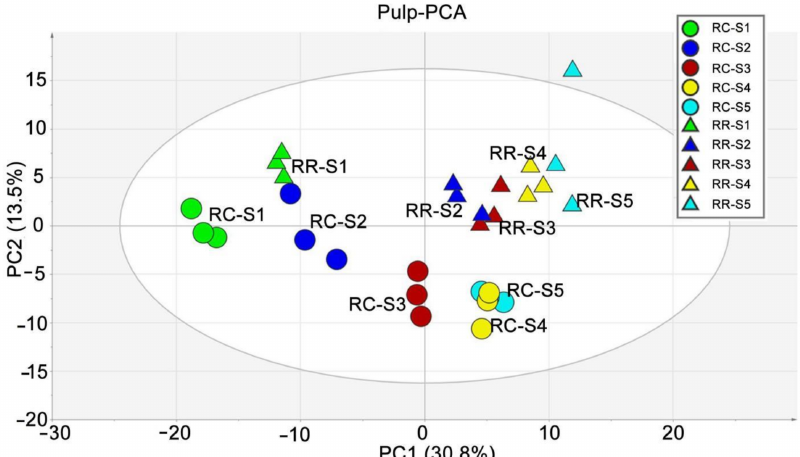
Figure 1. PCA of pulp at different berry developmental stages. Traditional cultivation (RC) and root restriction (RR) cultivation are represented by circles and triangles, respectively. Green, blue, brown, yellow, and cyan represent samples collected at S1, S2, S3, S4, S5 stage, respectively.